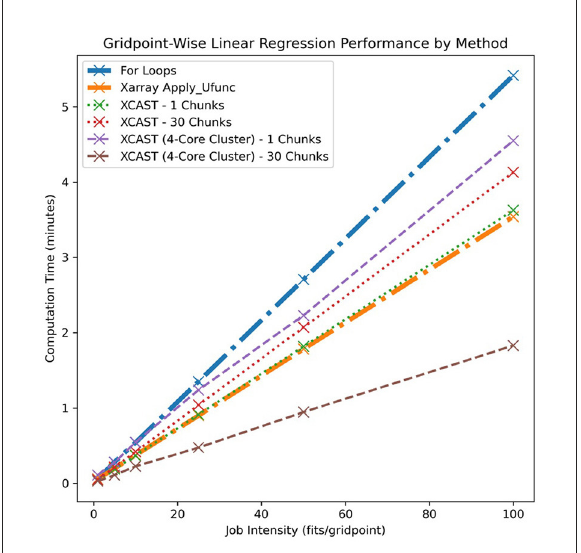
FIGURE3 The results of an experiment analyzing the comparative performance of six implementations of gridpoint-wise model fitting. Training time in fraction of minutes is plotted against the ensemble size as an analog for job intensity.